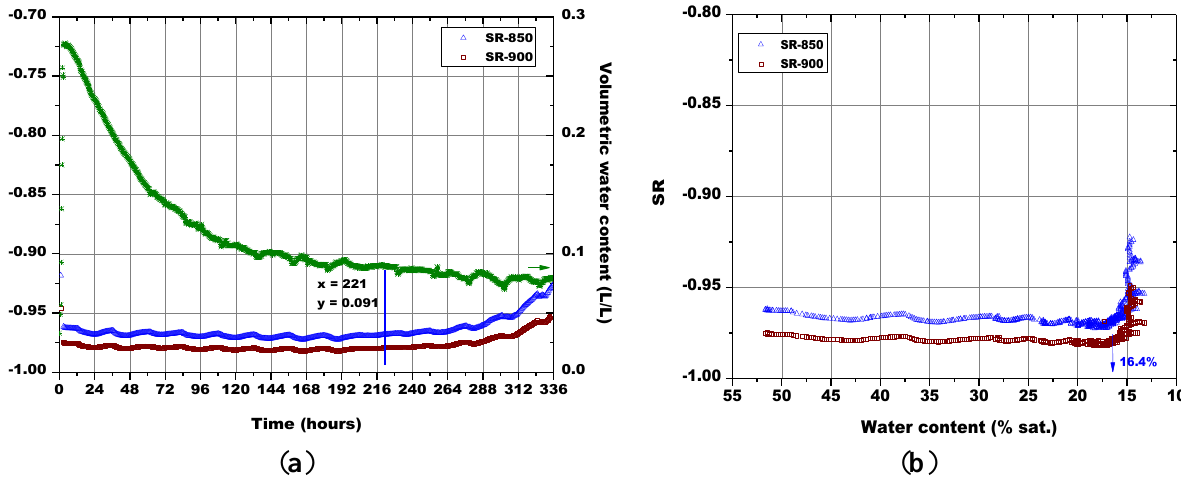
Figure 16. ( a ) Evolution of: the sensors response and of soil water content in function of time; ( b ) The sensors response in function of soil water content; comparison between the pellets fired at 900 °C and 1,000 °C (soil temperature = 45.0 °C ± 0.8 °C, soil density about 1.28 g/cm 3